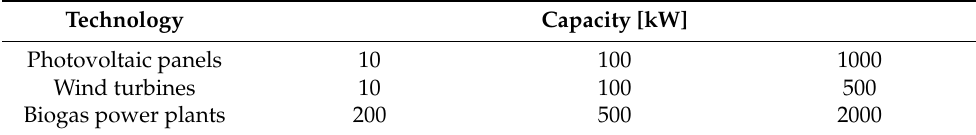
Table 1. Rated power of Renewable Energy Sources